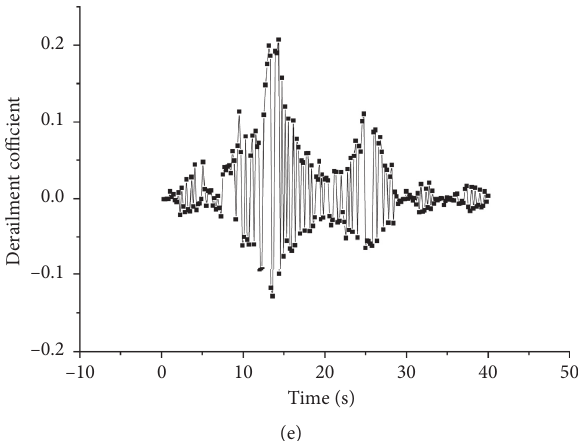
Figure 18: Wheel-track-subgrade time history under the El Centro wave. (a) Lateral acceleration-time curve of the wheel. (b) Lateral force- time curve between the wheel and rail. (c) Vertical force-time curve between the wheel and rail. (d) Wheel load reduction rate-time curve. (e) Derailment coefficient-time